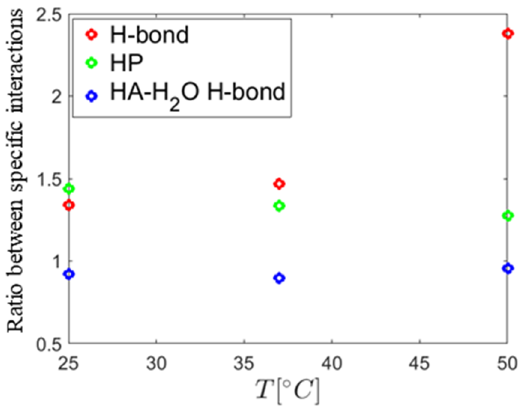
Figure 11. Ratios between the number of specific interactions found in CaCl 2 and NaCl solutions as a function of temperature. The hydrogen bonds between DPPC and HA are denoted by H-bond, the hydrophobic contacts between HA and DPPC are denoted by HP. The hydrogen bonds between water and HA are denoted by HA-H 2